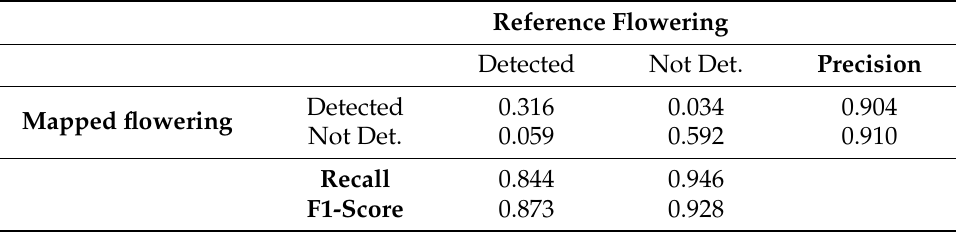
Table 1. A confusion matrix showing detected and not detected heavy flowering (proportion of map) for the ∆ NDYI method (Mapped), assessed against a human operator (Reference). The proportions were estimated from a random sample of 500 locations in the “heavy flowering detected” class (weighted by proportion of “heavy flowering detected” in map = 0.35) and a random sample of 500 locations in the “heavy flowering not detected” class (weighted by